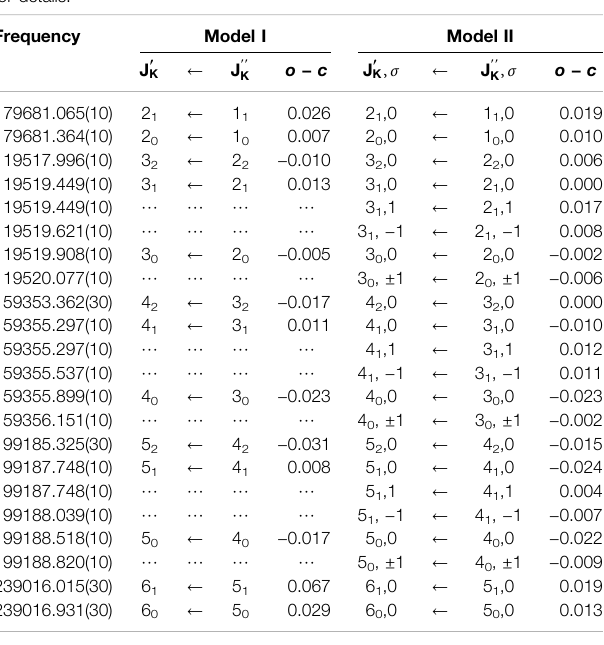
TABLE 2 | Frequencies of pure rotational transitions (in MHz) of CH 3 NH 3 + , obtained by fi tting multiple Gaussians to the spectra in Figure 1 . The uncertainties (1 σ ) are given in parentheses in units ofthe last signi fi cant digits. The assignment of Model I assumes a standard symmetric top Hamiltonian whereas that of Model II assumes a symmetric top featuring torsional splitting, see text for